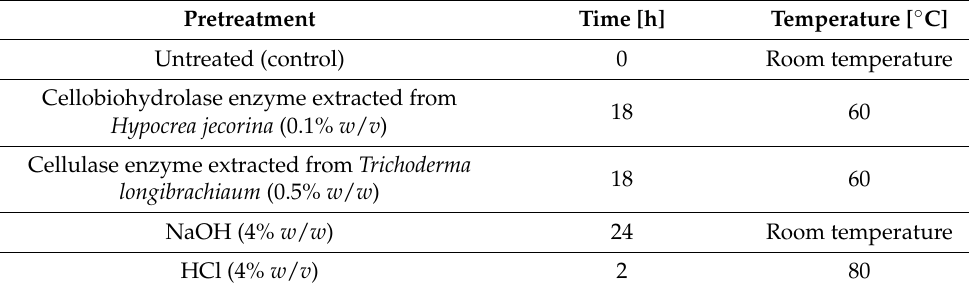
Table 1. Pretreatments applied to Ricinus communis